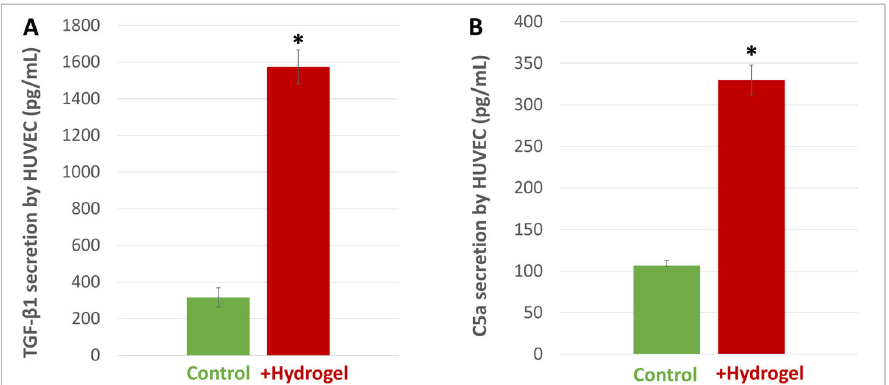
Figure 7. TGF- β 1 ( A ) and C5a secretion ( B ) by endothelial cells. After incubating HUVEC cells with the hydrogel for 72 h, enzyme-linked immunosorbent assay showed a significant increase in TGF- β 1 and C5a secretion as compared to the controls. Results are expressed in pg/mL. * indicates a statistical difference with the control ( p < 0.05).